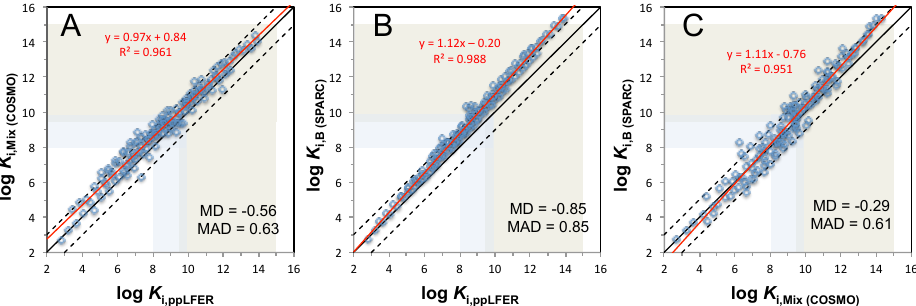
Figure 10. Plots comparing the partition coefficients at 25 ◦ C of alkanes and their oxidation products between the water-insoluble organic matter of aerosol and the gas phase predicted with three selected methods.